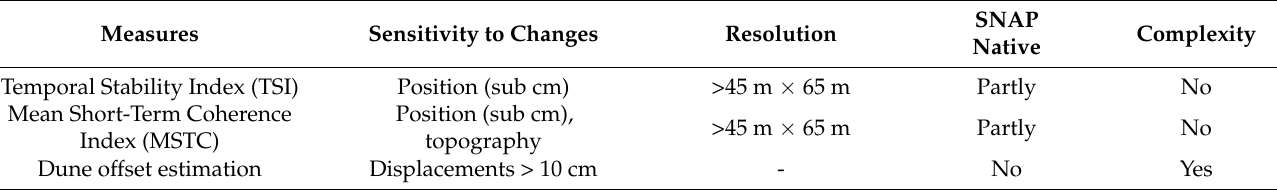
Table 2. Main characteristics of the SAR-derived